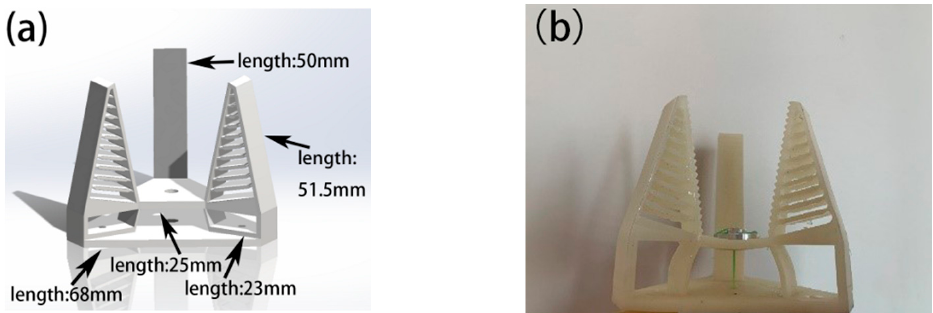
Figure 2. Conceptual drawing of a 3D-printed Fin Ray effect inspired soft robotic gripper: ( a ) 3D model; ( b ) real prototype.